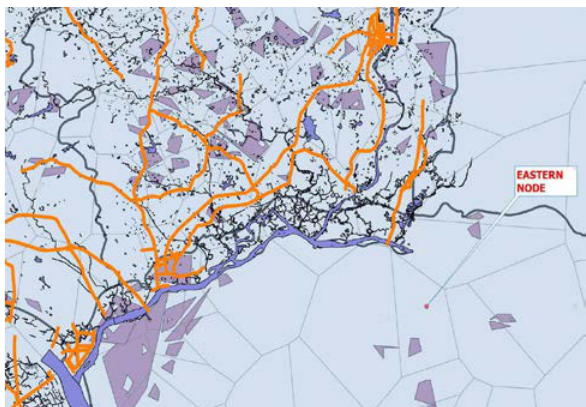
Figure 5: Third-Fourth level nodes of detail map. The purple zone is single afforest patch land. Blue double lines are rivers and yellow lines are main